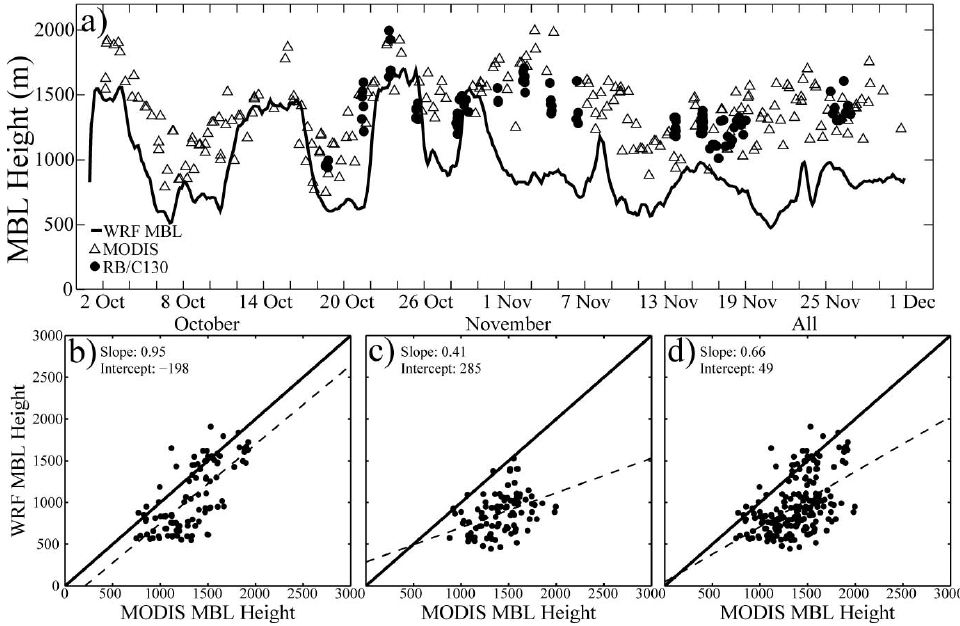
Fig. 4. (a) Time series of MBL height (m) from the C130 and Ron Brown (circle), MODIS (triangle), and WRF (black line) at Point Omega (20 ◦ S, 80 ◦ W). Comparison of MODIS and WRF MBL depth (m) for (b) October, (c) November, and (d) the entire two months. The one-to-one line is the bold line and the linear fit is the dashed line. simulated MBL is typically 200 m lower than those